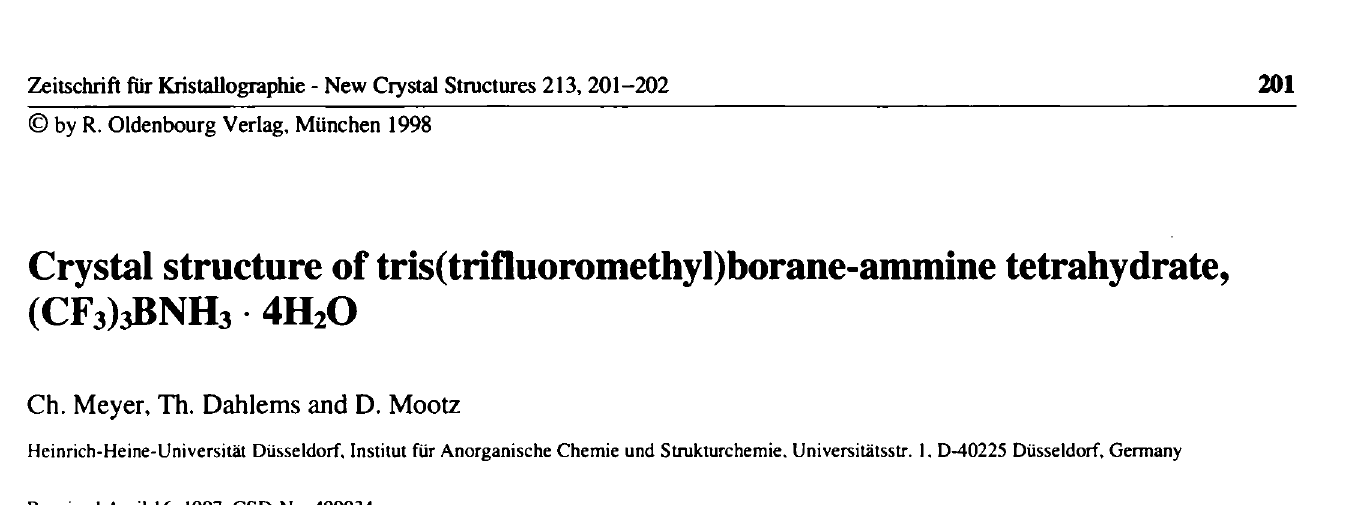
Table 1. Parameters used for the X-ray data collection Crystal: